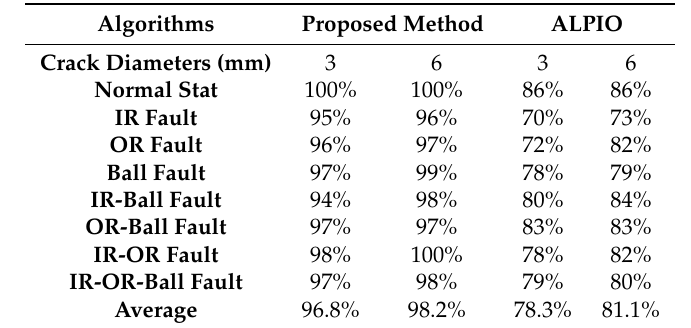
Table 3. Fault diagnosis results using dataset 2 with the proposed method and ARX-Laguerre proportional integral observation (ALPIO) when the torque speed is 400 RPM.